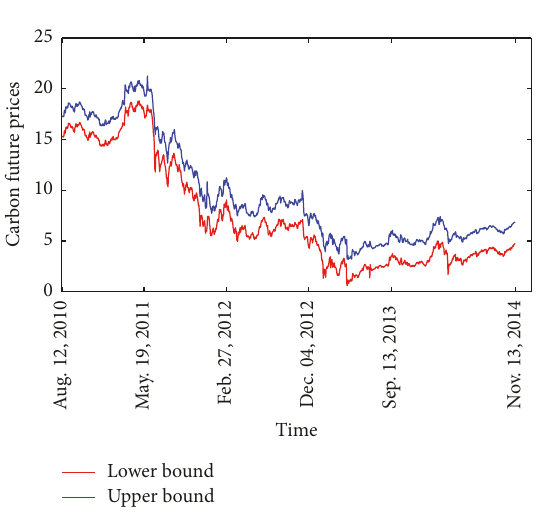
Figure 2: Interval-valued carbon futures prices